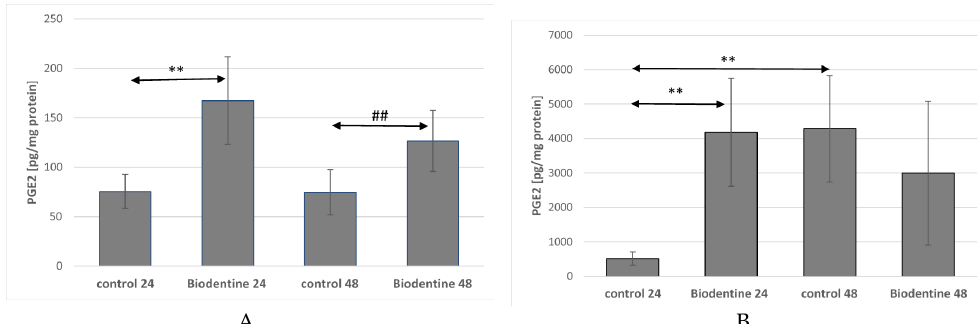
Figure 5. The concentration of prostaglandin E2 (PGE2) in THP-1 monocytes ( A ) and macrophages ( B ) cultured with Biodentine TM Cells were cultured for 24 h and 48 h in RPMI medium with 10% FBS with Biodentine TM , after incubation the cells were harvested by scraping and PGE2 concentration was measured by ELISA method. Control cells were incubated in RPMI medium with 10% FBS.